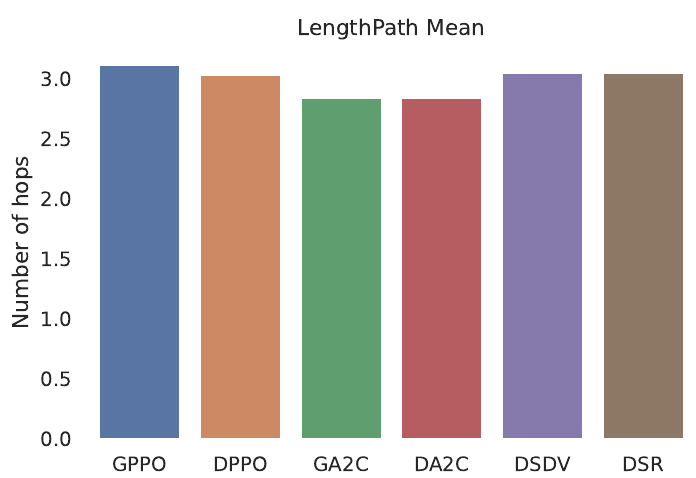
Figure 6. Hop number of the chosen path.